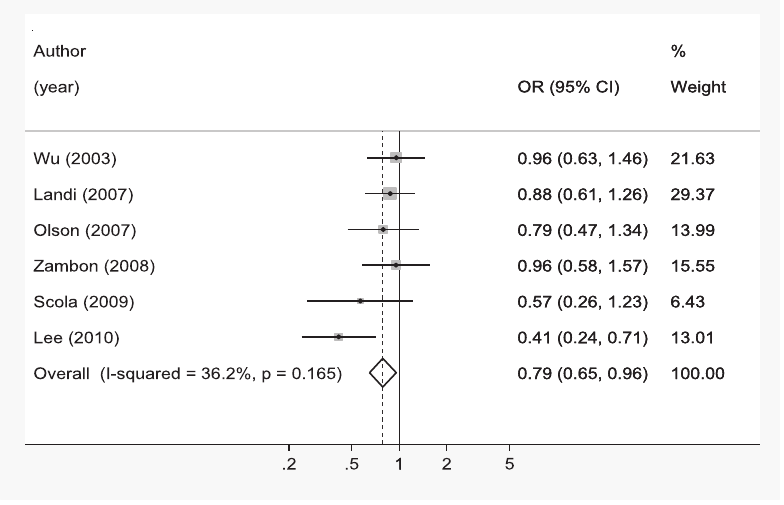
Fig. 4. Forest plot of gastrointestinal cancer risk associated with IL4R 1801275 (AG vs. AA). CI, con fi dence interval; OR, odds